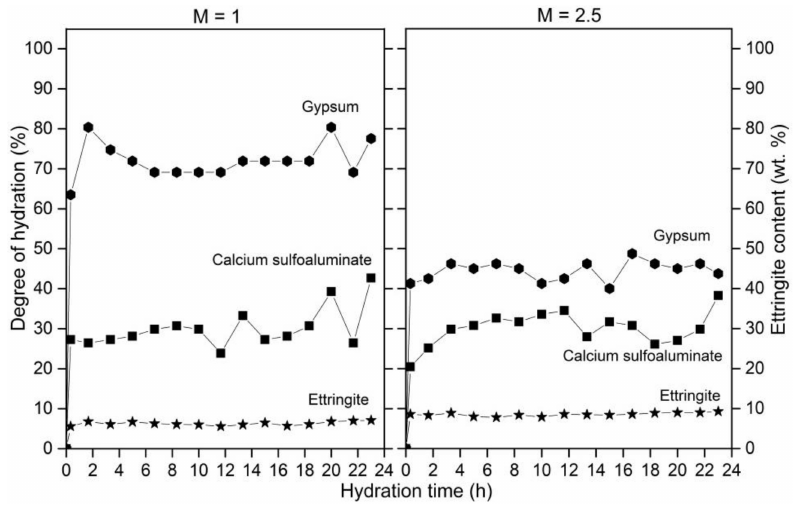
Figure 8. Degree of hydration of calcium sulfoaluminate and gypsum with ettringite content during first 24 h of hydration of the M = 1 and M = 2.5 samples at 60 ◦ C. At a molar ratio of 2.5, the following phases were identified: belite, calcium sulfoalumi- nate, ferrite, gypsum, gehlenite, periclase, and ettringite, in addition to amorphous